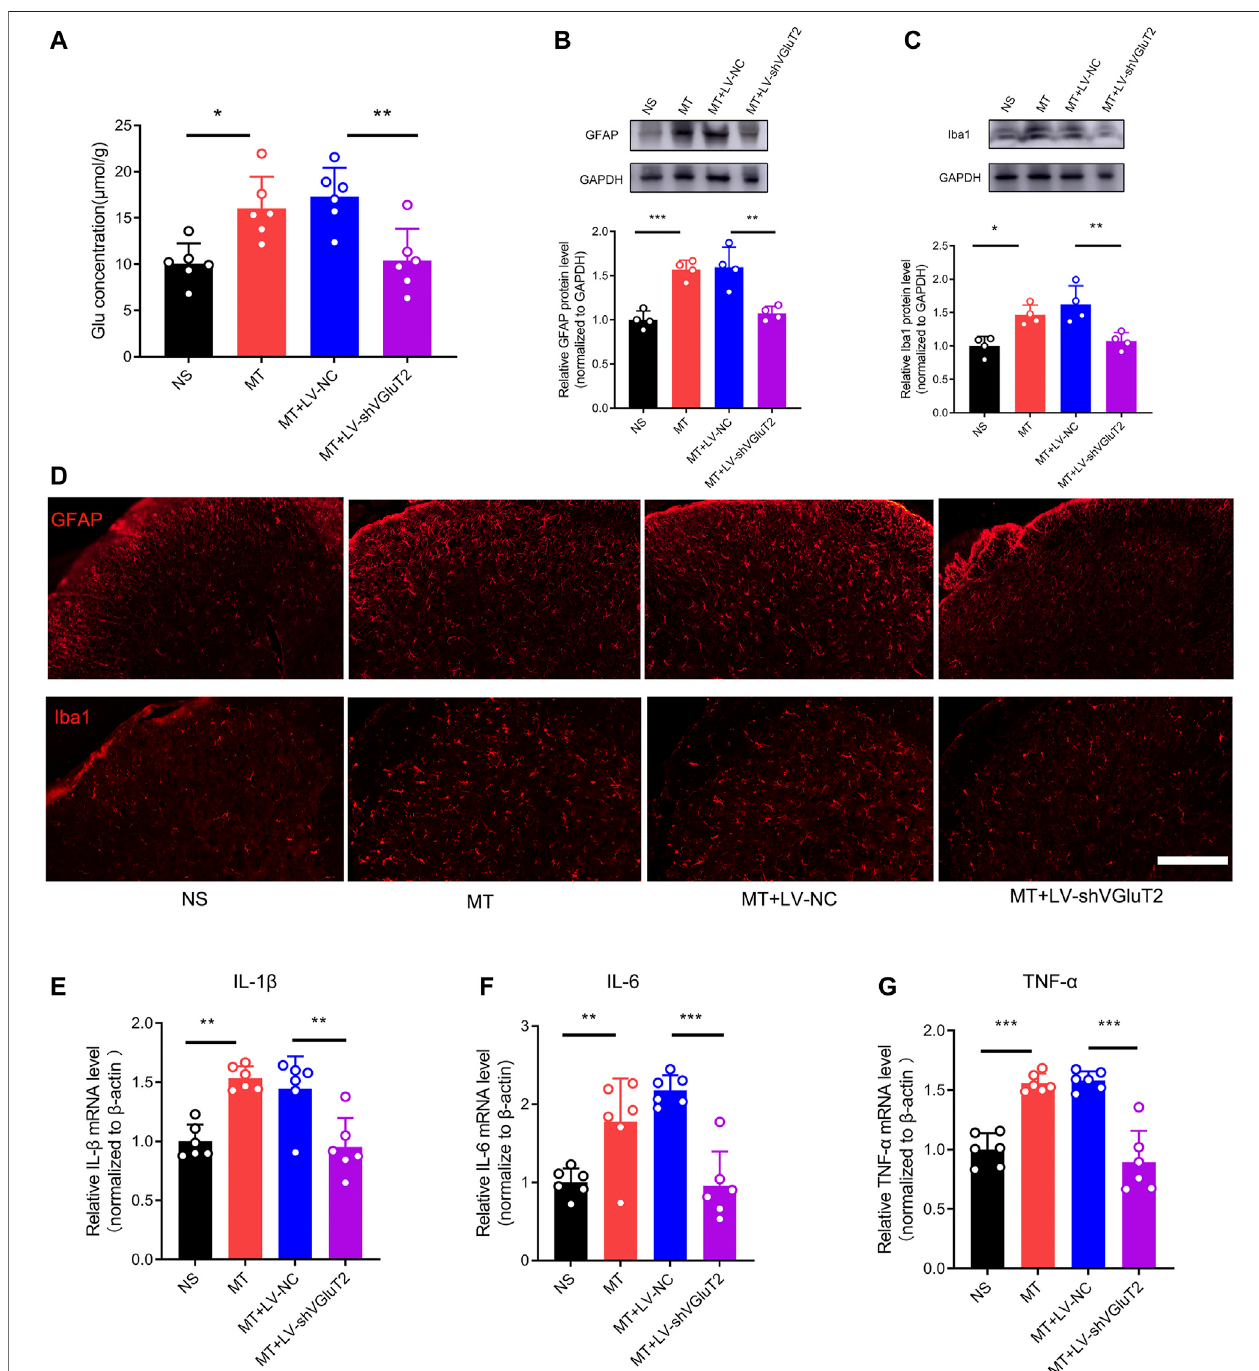
FIGURE 5 | Knockdown of VGluT2 decreases glutamate concentration and suppresses glial cells activation and release of pro-in fl ammatory cytokines (A) Glutamate concentration assay showing knockdown of VGluT2 reduces spinal glutamate concentration. n = 6, one-way ANOVA, F (3, 20) = 8.938, p = 0.0006 (B,C) Western blotting test showing LV-shVGluT2 decreased GFAP (B) and Iba1 (C) expression in mice spinal cords. n = 4, One-way ANOVA (B) F (3, 12) = 19.97, p < 0.0001 (C) F (3, 12) = 10.67, p = 0.0011, with Bonferroni correction (D) Representative immuno fl uorescent images showing knockdown of VGluT2 reduces morphine-induced upregulation of GFAP and Iba1. n = 4, Scale bars, 100 μ m (E-G) RT-PCR showing morphine induces-upregulation of pro-in fl ammatory cytokines were decreased by knockdown of VGluT2. n = 6, One-way ANOVA (E) F (3, 20) = 12.97, p < 0.0001 (F) F (3, 20) = 15.31, p < 0.0001 (G) F (3, 20) = 31.37, p < 0.0001. * p < 0.05, ** p < 0.01, *** p < 0.001. The samples used for all tests in this fi gure are harvested from mice after 7-days repeated morphine administration.